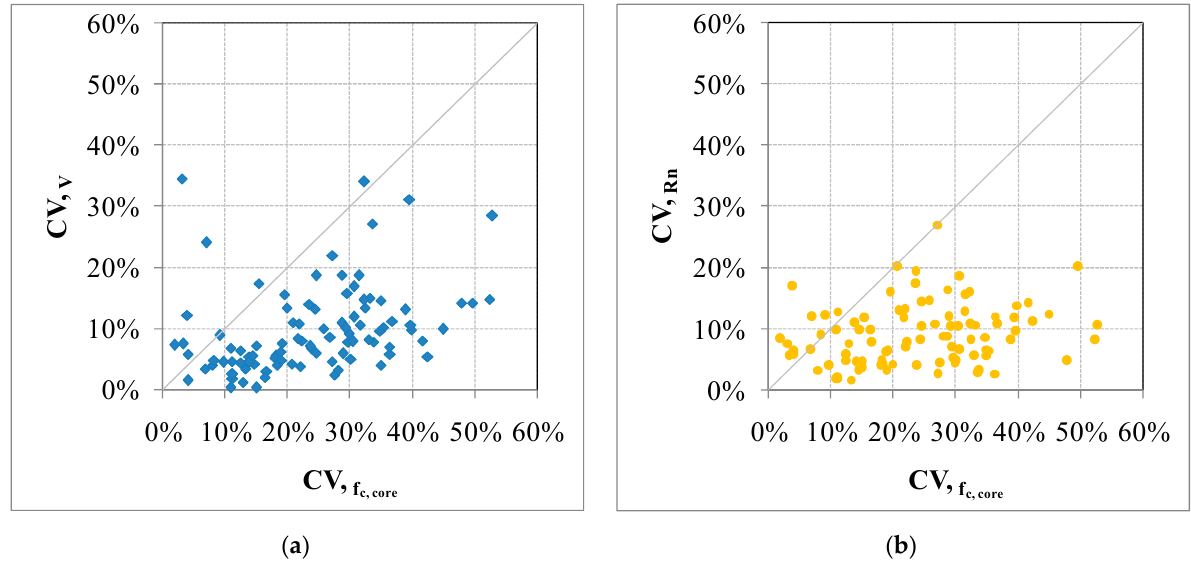
Figure 9. Relationship between DTs–NDTs within each building: rebound number ( a ) and ultrasonic velocity ( b ) tests.